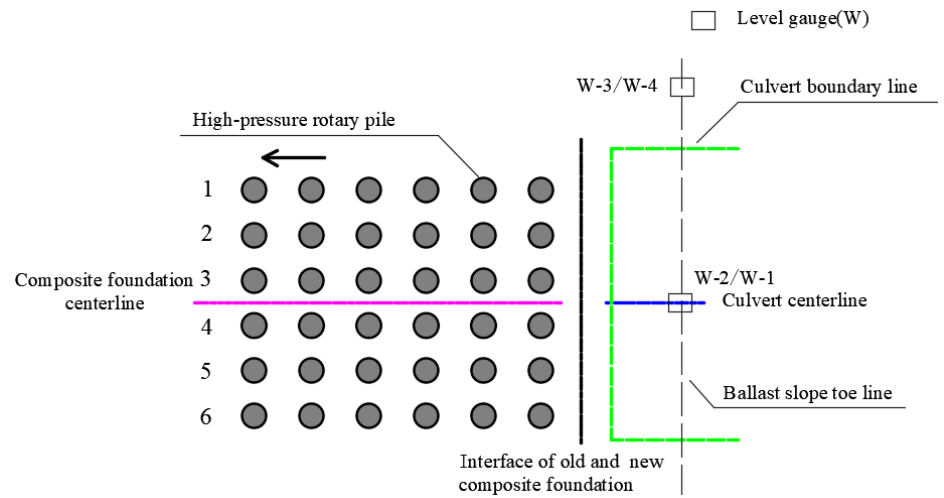
Figure 7. Diagram of the construction sequence of high-pressure rotary piles in the culvert extension section.